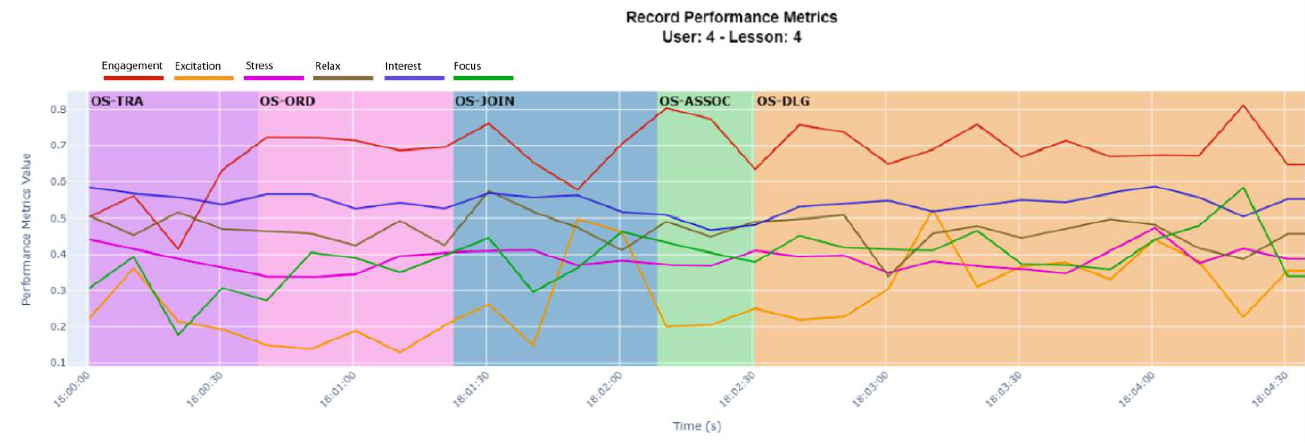
Figure 13. Record performance metrics.